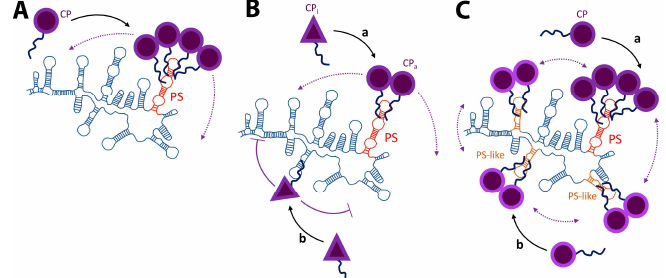
Figure 1. PS-mediated packaging mechanisms. ( A ) High-affinity binding mechanism. Selective packaging of the genomic RNA (gRNA) is mediated by high-affinity binding between the capsid protein (CP) and the packaging signal (PS). In this scenario the PS is one small RNA element (and/or sequence) present only in the gRNA. ( B ) PS allosteric mechanism. Binding of the CP to the PS is an allosteric switch that changes the conformation of the CP from one with weak CP-CP interactions (CPi) to one strong interactions (CPa). ( C ) Multiple PS-like elements. There is one PS and a series of PS-like elements distributed across the gRNA. The interaction between the PS and the CP (a) are stronger than between the PS-like elements and the CP (b). Unlike the first two scenarios, all these clusters contribute to the nucleation of virion assembly. In all cases the unstructured tail represents the CP N-terminal domain. For most (+)ssRNA viruses the N-terminal domain of the CP is extremely basic and is required for RNA/CP interactions and RNA